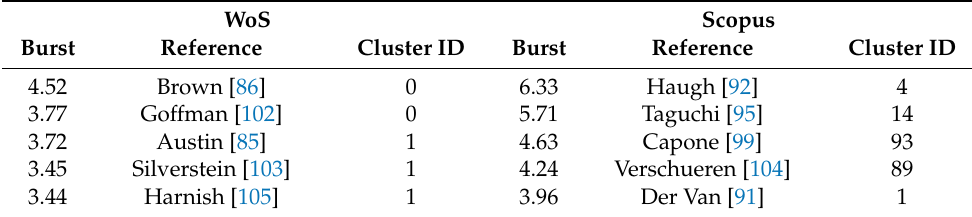
Table 6. Bursts detection for research on